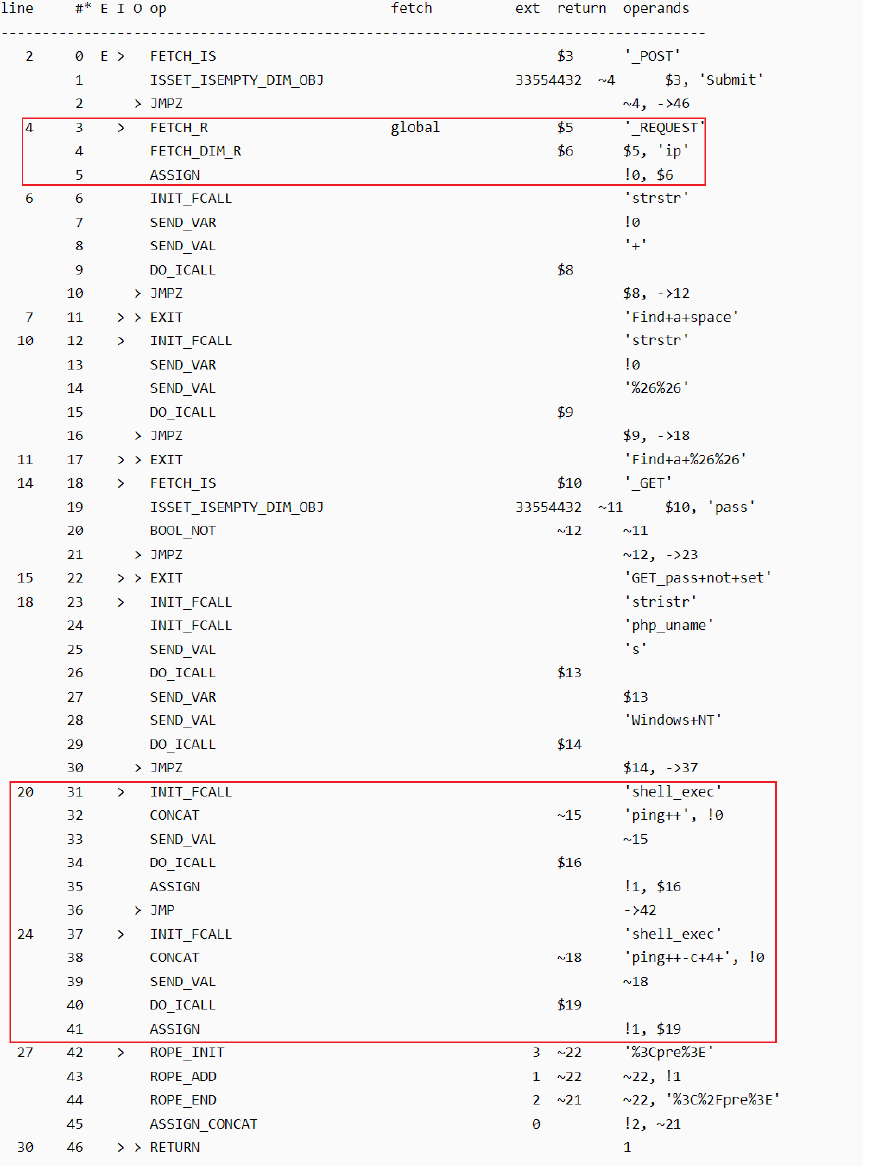
Figure 5 . Opcodes converted form sample code